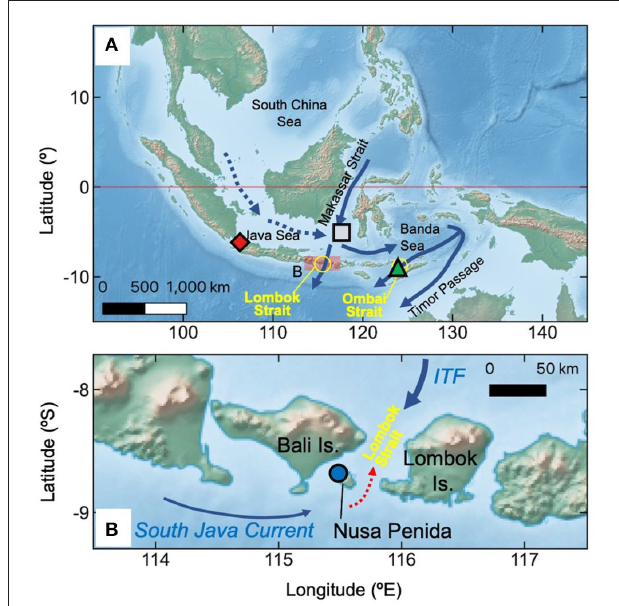
FIGURE 1 | (A) Map of the Indonesian Seas. Solid arrows indicate the Indonesian Throughflow (ITF) from the Pacific Ocean to the Indian Ocean. Dashed arrows indicate sea surface currents from the South China Sea to the south end of Makassar Strait during the northwest monsoon. Symbols indicate sampling site in the previous study: (red diamond) Seribu Islands ( Genda et al., 2022), (gray square) southern Makassar Strait (Murty et al., 2017), and (green triangle) Ombai Strait ( Cahyarini et al., 2014). (B) Map of Lombok Strait showing sampling site location (blue circle) on the northwest side of Nusa Penida, which is the enlargement of pinky shaded area in (A) . The red dotted arrow indicates the northward surface flow in Lombok Strait during the northwest monsoon. Panels A and B are made with Natural Earth (https://